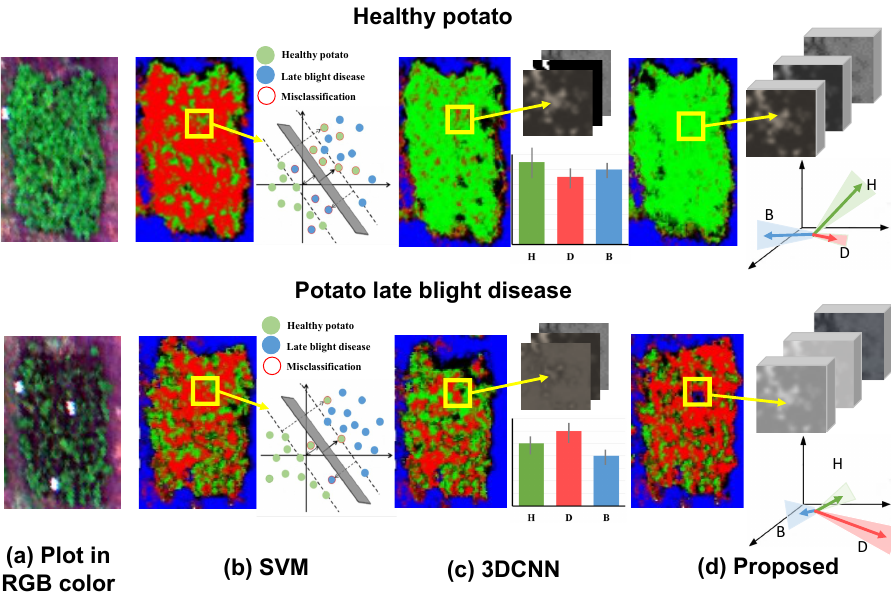
Figure 7. The visualized feature space and the mapping results of the healthy and diseased plots based on the different machine learning/deep learning methods: ( a ) the original RGB image for the healthy potato (H), diseased potato (D) and background (B). ( b ) The classification results and